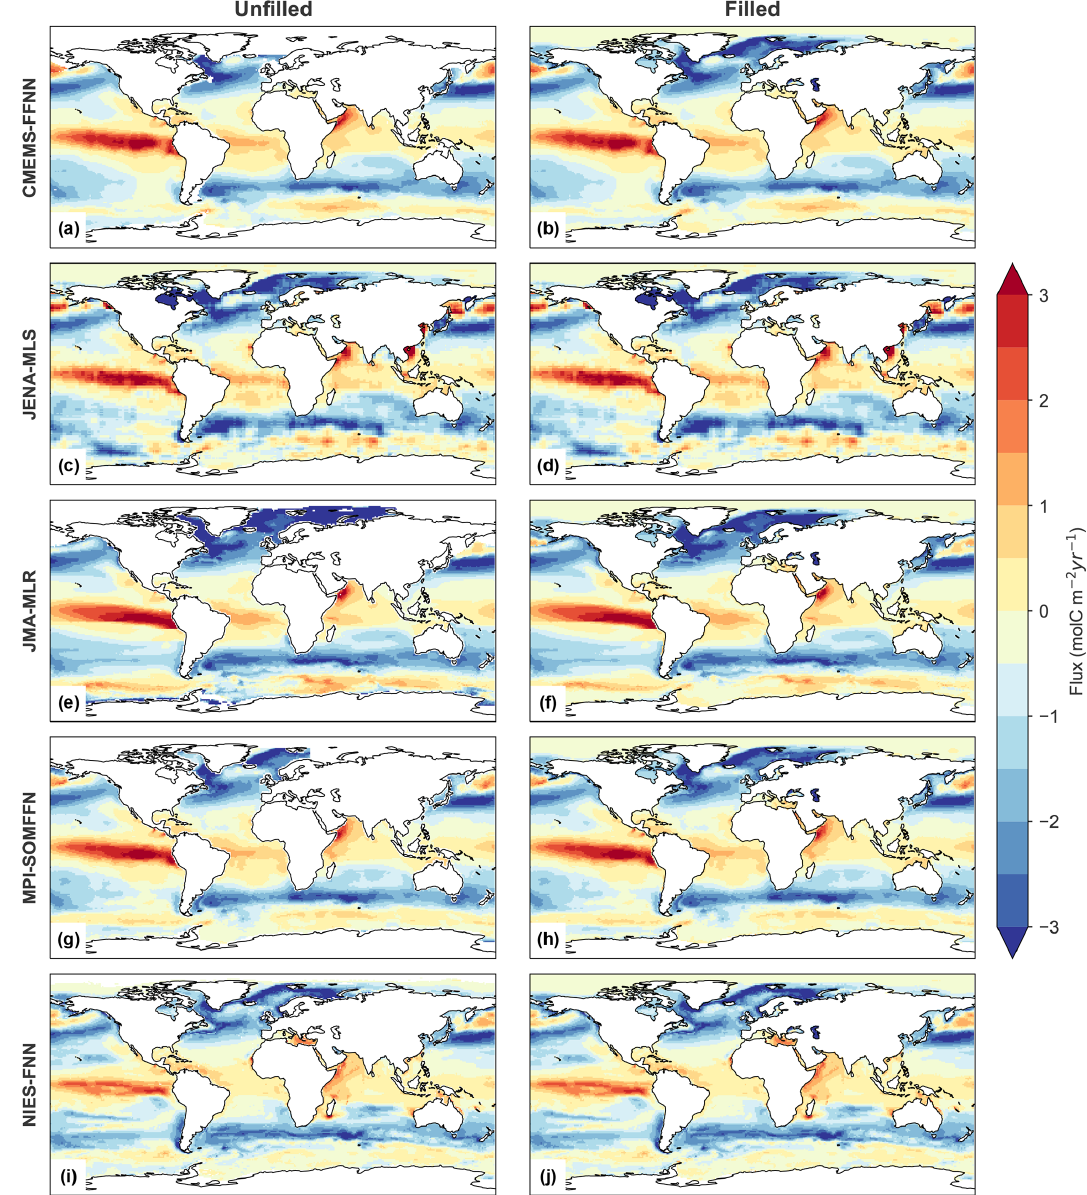
Figure A5. Mean flux (molm − 2 yr − 1 ) for 1990–2019. Left-hand column: map of mean-calculated flux using the unfilled p CO 2 product and three scaled wind products. Right-hand column: map of mean-calculated flux using the filled p CO 2 product and three scaled wind products.